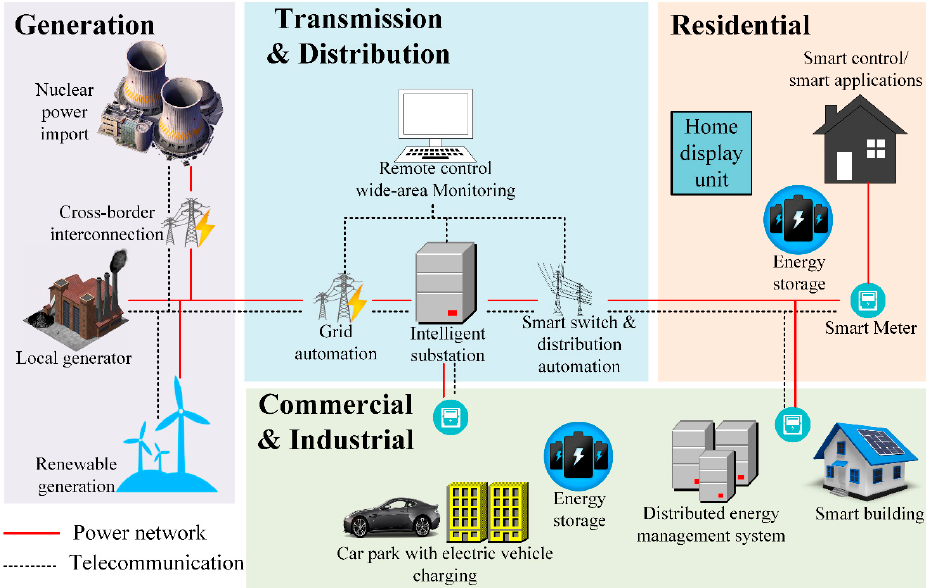
Figure 1. The overall smart grid concept. It is capable of providing electrical power from multiple and widely distributed sources, such as from wind turbines, solar power systems, and plug-in hybrid electric vehicles. It uses digital automation technology for monitoring, control, and analysis through the supply chain [22].